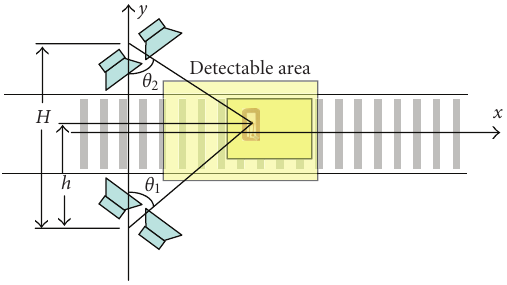
Figure 6: Tag localization using two oblique arrays.